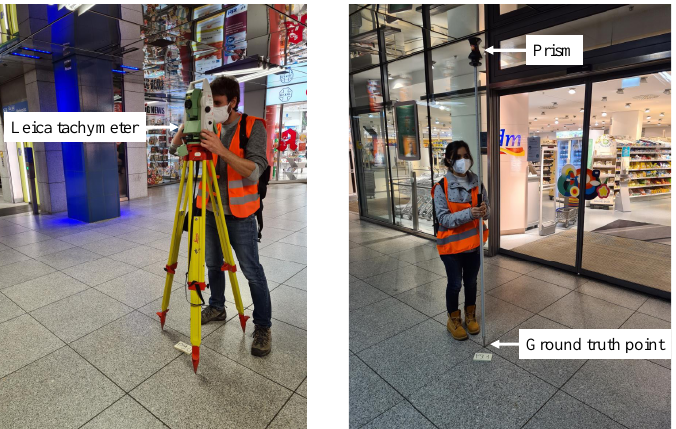
Figure 5. ( Left ) The Leica tachymeter station which measures the distance to the prism. ( Right ) The prism placed at a pre-defined